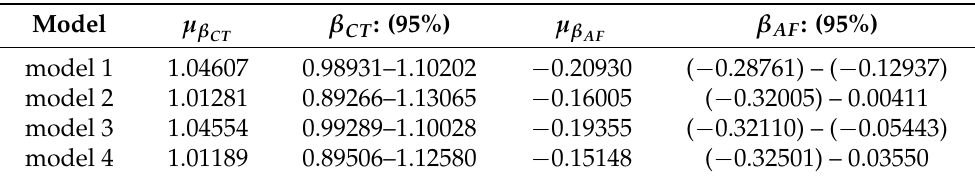
Table 3. Parameters of Bayesian predictive distribution for each model. Means and prediction interval (95%) of the posterior distribution for β CT and β AF